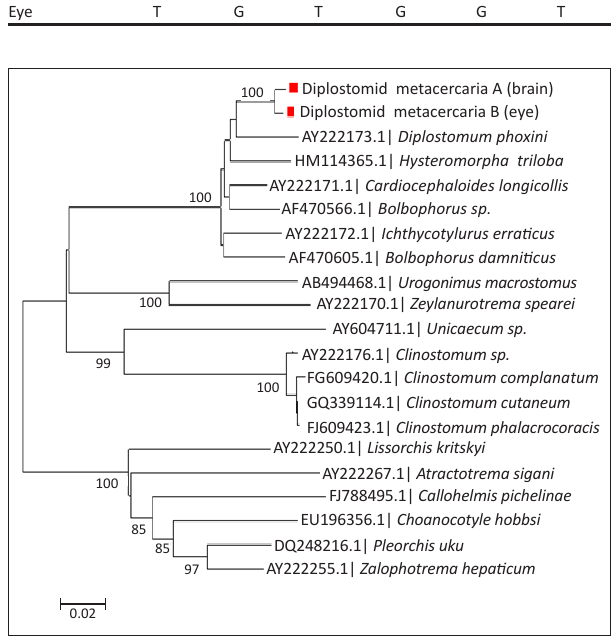
FIGURE 4: A phylogenetic tree showing the brain and eye diplostomids in relation to other parasites from the GenBank